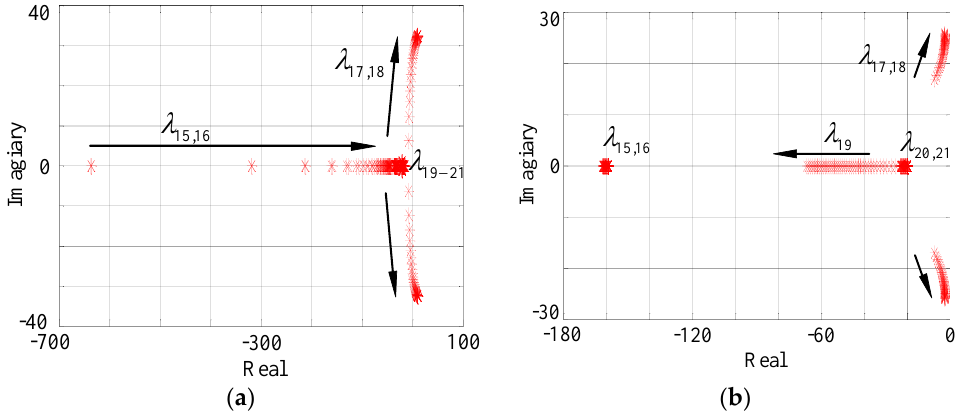
Figure 12. Eigenvalue loci (only the important eigenvalues shown) for a parametric sweep of the droop coefficient: ( a ) D p 1,2 in a range from 0.00005 to 0.002; and ( b ) D q 1,2 in a range from 0.00015 to 0.006.